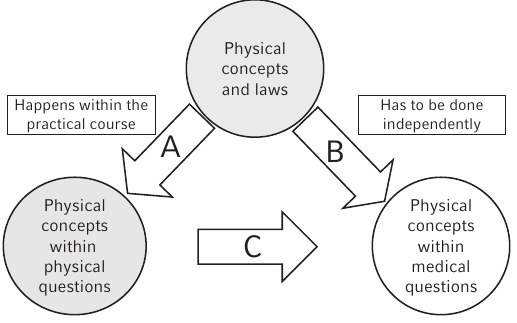
FIG. 1. Standard experiments (cid:1) gray (cid:2) within physical and medi- cal domains. For details concerning the arrows A, B, and C see text.